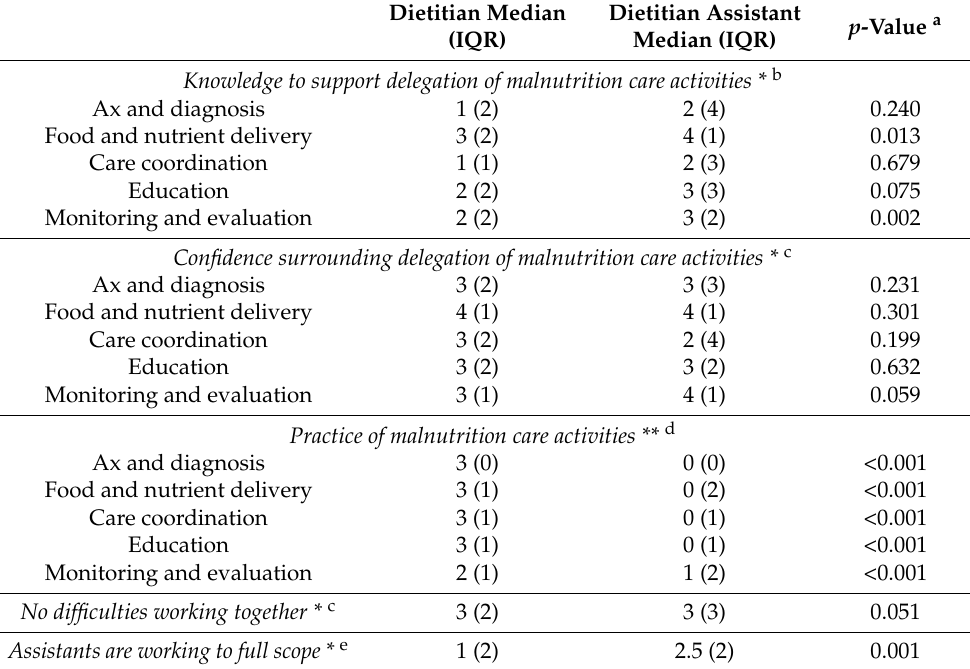
Table 3 provides a summary comparison of the median Likert scale responses between the dietitian and dietitian assistant respondents. Table 3. A comparison of the median Likert scale score responses between dietitian and dietitian assistant